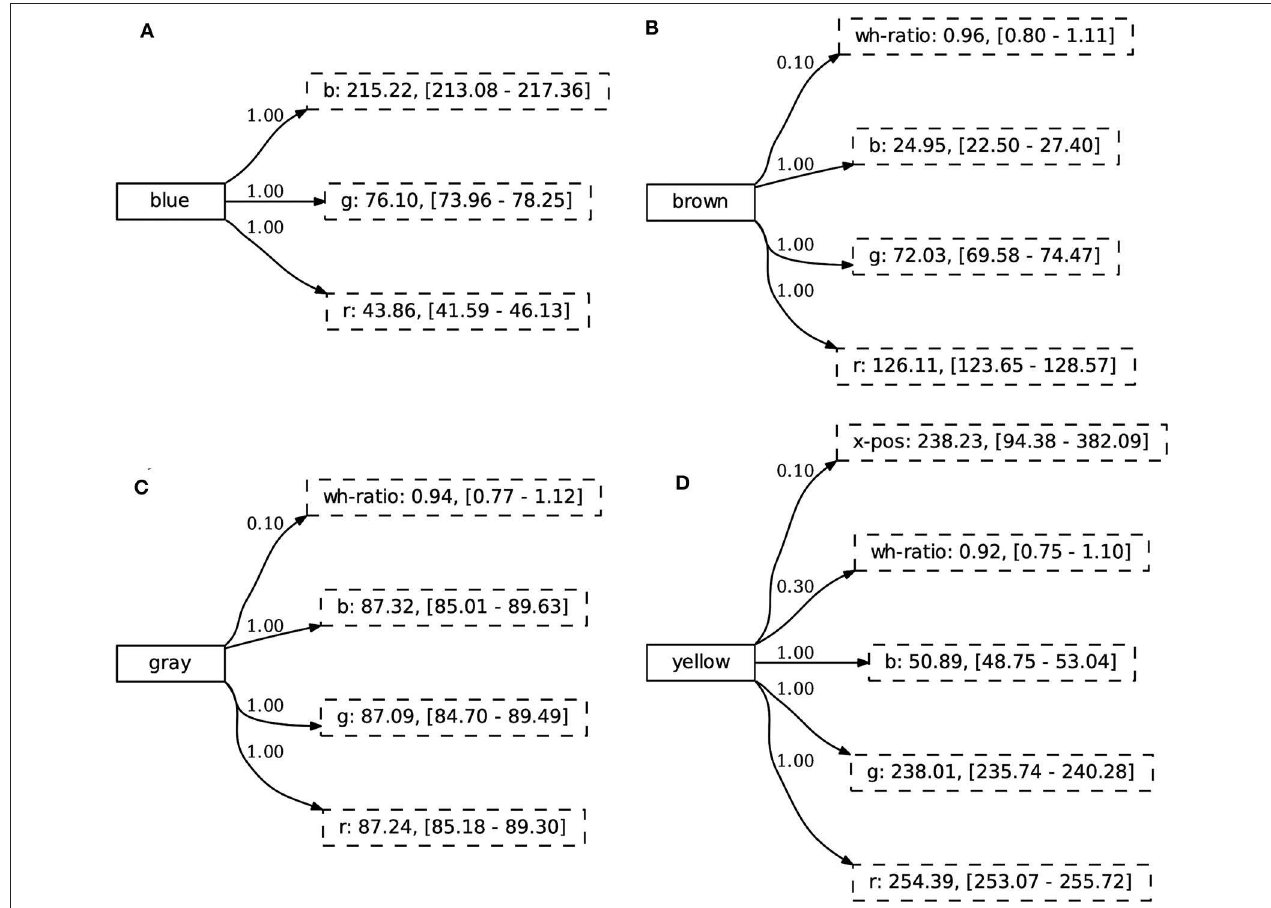
FIGURE 9 | A subset of the agent’s repertoire of concepts after the generalization experiment. In condition A, the concepts BLUE (A) , BROWN (B) , GRAY (C) , and YELLOW (D) are always observed as cubes or spheres. The agent is not “distracted” by statistical distributions of the environment and learns combinations of attributes that are relevant to solve the communicative